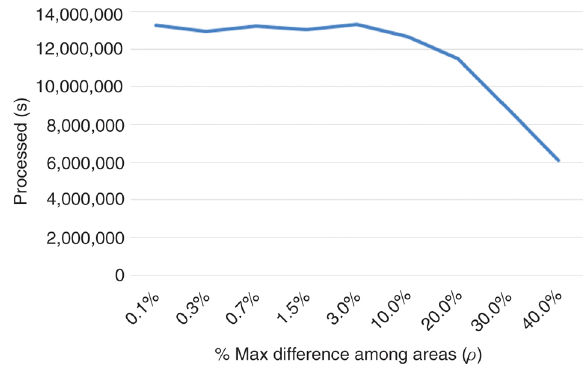
Figure 5: Number of cells processed per second with respect to ρ